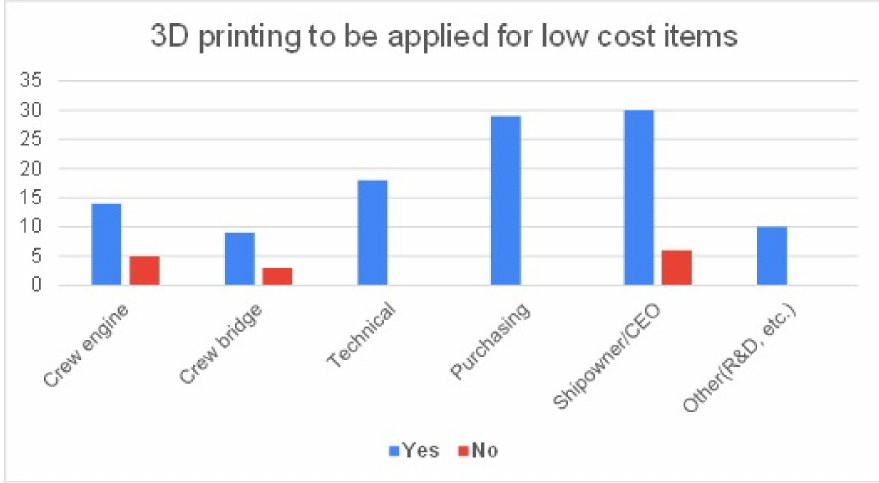
Figure 8. Response to whether 3D printing could be applied for low-cost items.